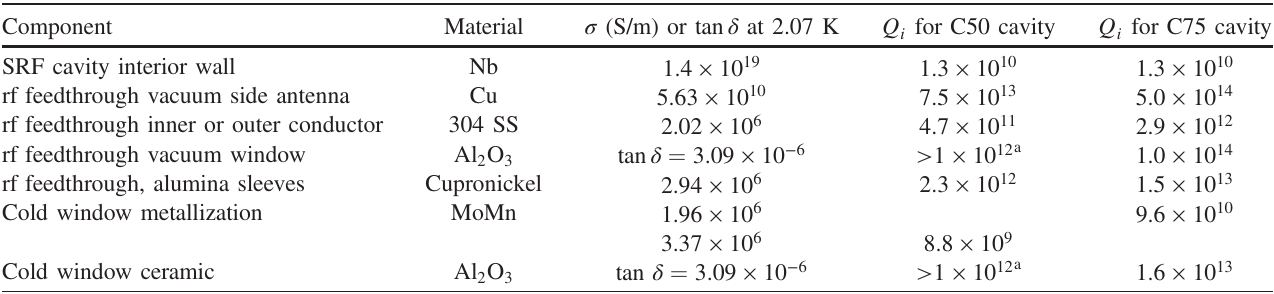
TABLE II. Numerically computed Q values of individual components as present in a C50 and C75 cavity-pair VTA test configuration.